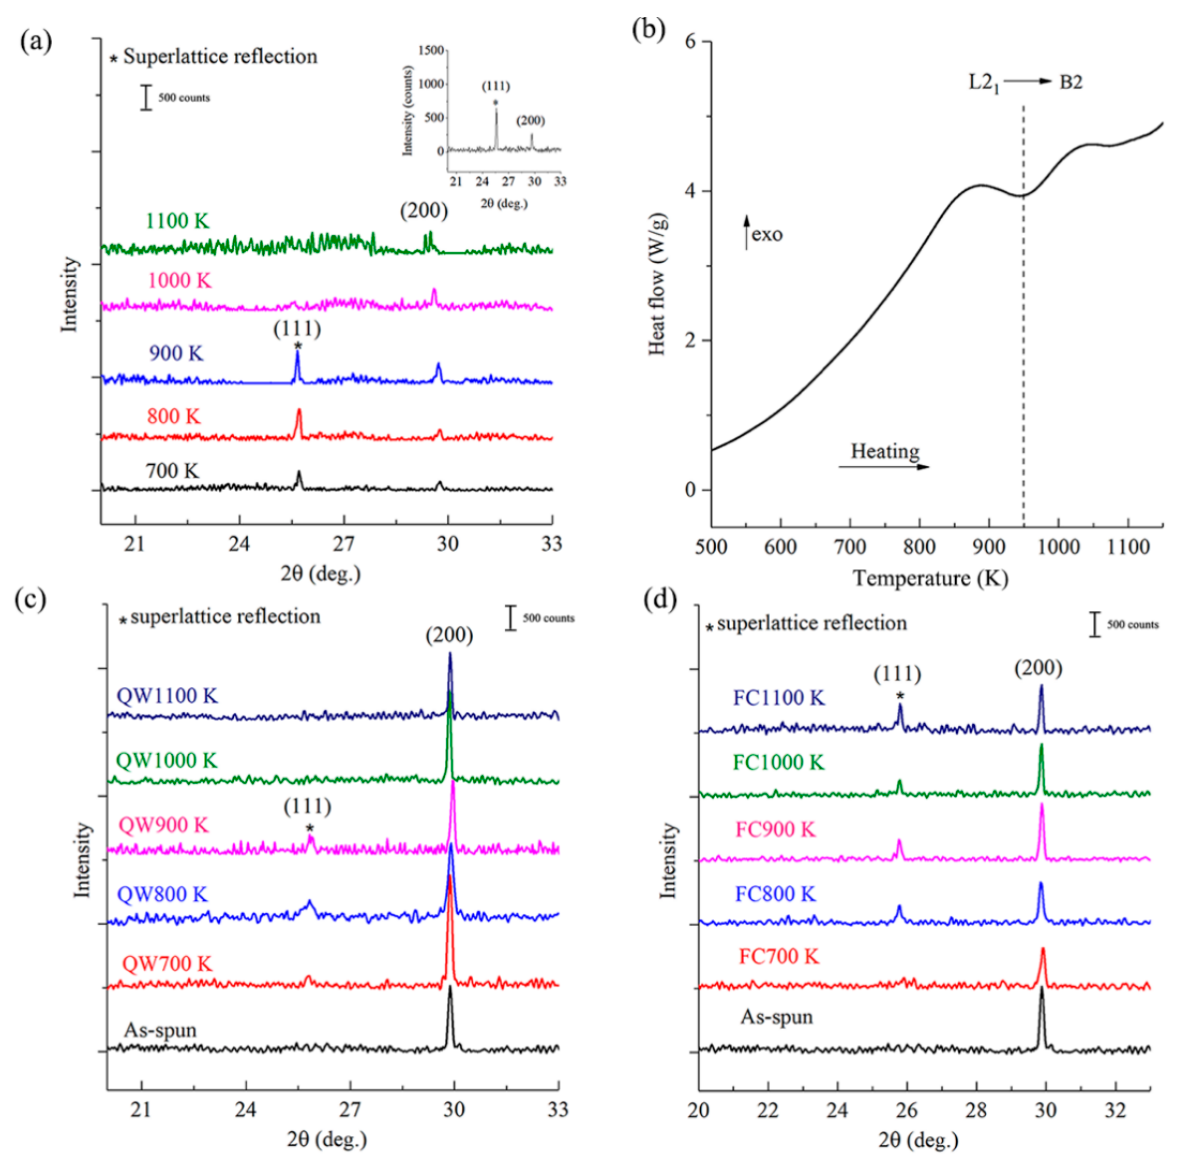
Figure 1. ( a ) (111) reflections of in situ heating powder XRD (X-ray diffraction) analysis. The inset is the (111) reflec- tion of long-time annealed Ni 45 Co 5 Mn 36.6 In 13.4 ribbons. ( b ) DSC (Differential Scanning Calorimetry) heating curves of Ni 45 Co 5 Mn 36.6 In 13.4 ribbons and the transition temperatures were determined by tangent method on the endothermic peak. ( c ) (111) reflections of XRD analysis of as-spun and QW (ice-water quenching) Ni 45 Co 5 Mn 36.6 In 13.4 ribbons and ( d ) that of as-spun and FC (furnace cooling) Ni 45 Co 5 Mn 36.6 In 13.4